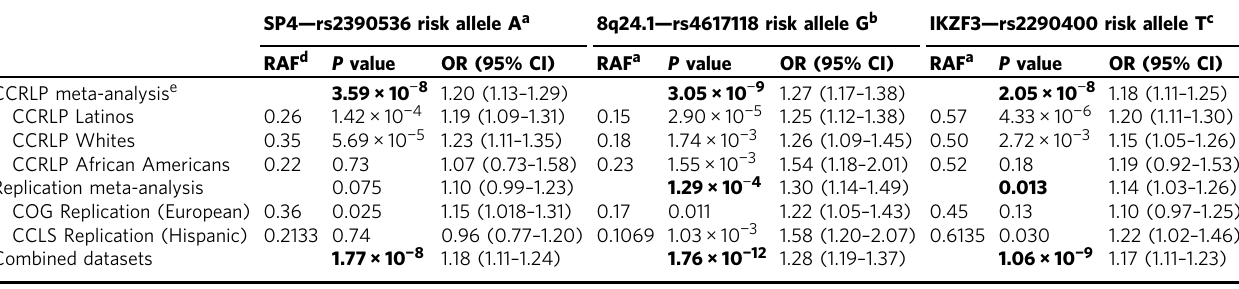
RAF risk allele frequency, CCLS California Childhood Leukemia Study, CCRLP California Cancer Records Linkage Project, COG Children ’ s Oncology Group. Bold values indicate P values lower than genome-wide signi fi cance ( P o 5×10 − 8 ) for CCRLP GWAS and combined datasets, and nominal signi fi cance ( P o 0.05) for replication meta-analysis. a Rs2390536 was genotyped “ on array ” for all sample sets apart from COG Replication (Imputed INFO score = 0.99) b rs4617118 was genotyped “ on array for CCRLP datasets, and imputed for COG Replication (INFO = 0.96) and CCLS Replication (INFO = 0.88) c rs2290400 was genotyped “ on array ” for all sample sets apart from COG replication (INFO = 0.88) d RAF calculated among ethnicity-matched controls e Sample sizes for all analyses: CCRLP Latinos: 1949 cases, 8584 controls; CCRLP whites: 1184 cases, 3551 controls; CCRLP African Americans: 130 cases, 3842 controls. For the replication: COG: 959 cases, 2624 controls; CCLS: 530 cases and 511